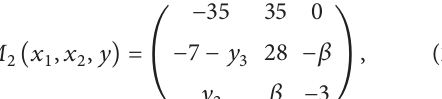
Figure 2: Chaotic attractors of fractional-order Lu system (26) for = 0.95 . 𝑞 𝑑2